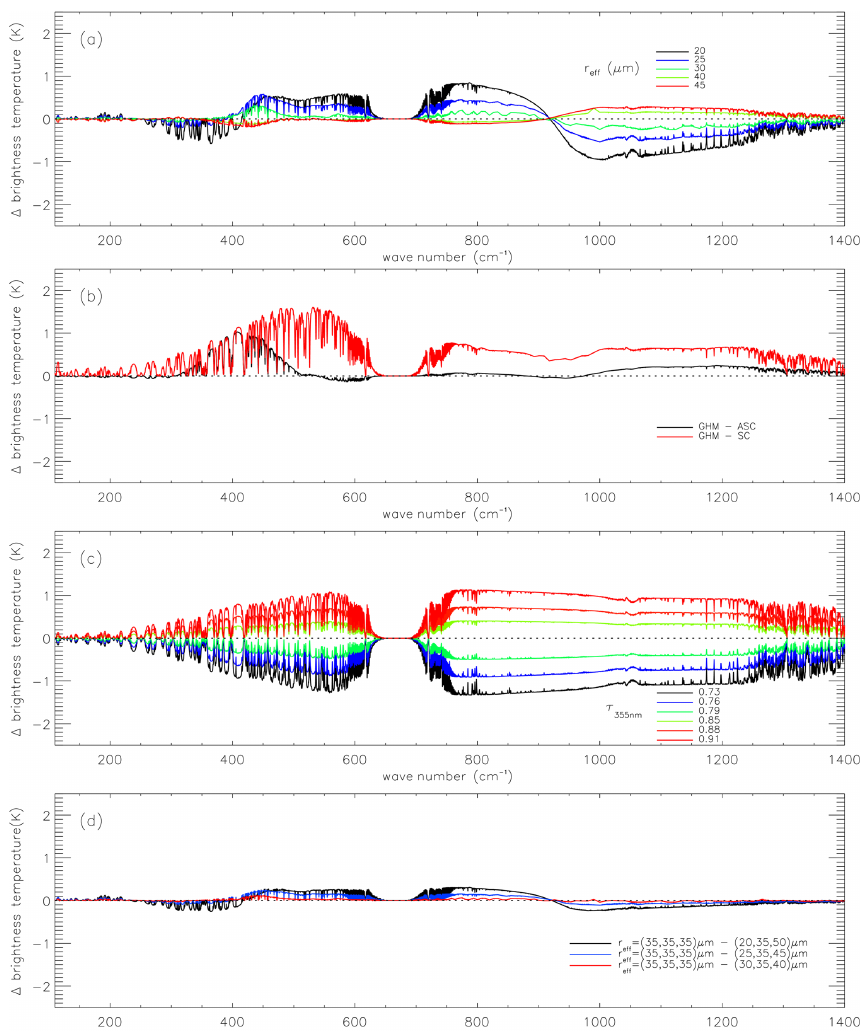
Figure 6. Simulated brightness temperature difference spectra to illustrate where there is sensitivity to r eff (a) , particle habit (b) and τ 355 (c) . Panel (d) illustrates the effect of varying r eff in three 1km thick layers through the cloud, with smaller crystals assumed at the top. In all panels, the differences are relative to a simulation using the GHM model assuming τ 355 = 0 . 82 and r eff =